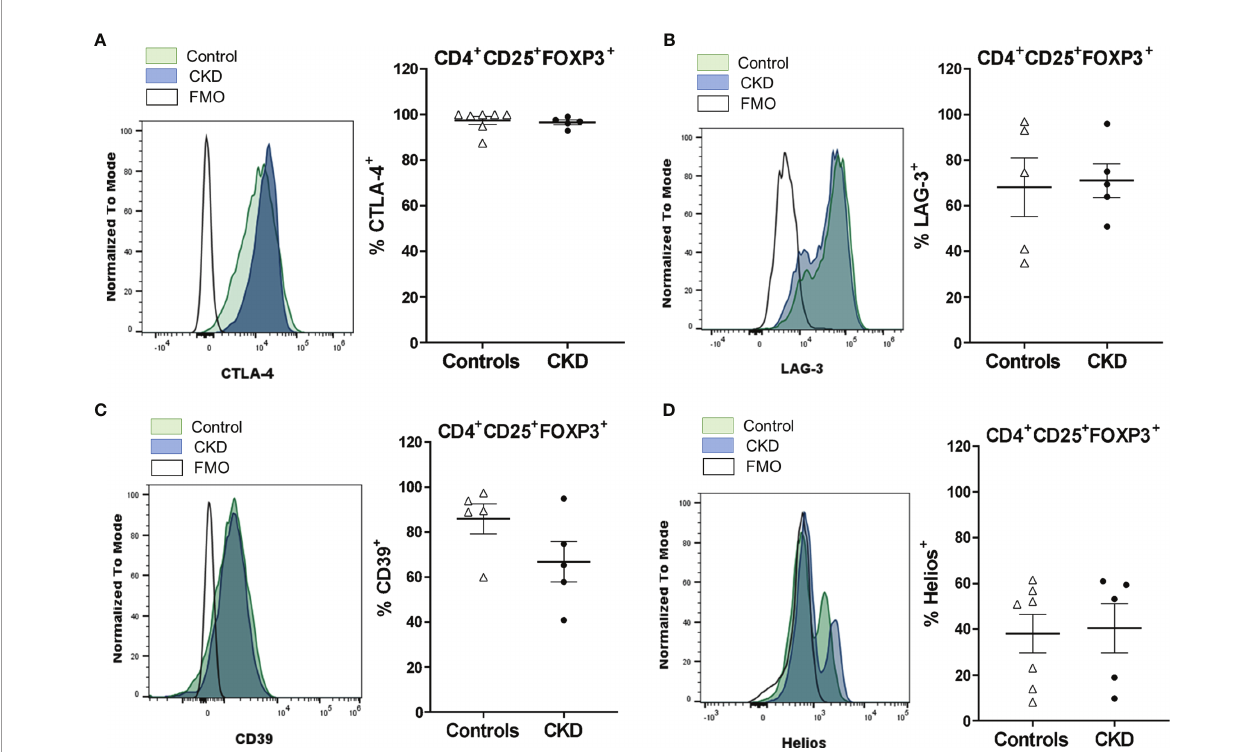
FIGURE 3 | Long-term expanded alloantigen-speci fi c regulatory T cells ( allo Tregs) had high expressions of CTLA-4, LAG-3, and CD39. Highly puri fi ed allo Tregs from healthy controls ( white triangles , n = 5-7) or patients with chronic kidney disease (CKD) ( black circles , n = 5) were polyclonally expanded for 4 weeks and then were stained with fl uorochrome-conjugated antibodies for analysis by fl ow cytometry. (A – D) Analysis of typical Treg markers showed that the expanded allo Tregs from both healthy individuals and patients with CKD had high proportions of CTLA-4 + (A) , LAG-3 + (B) , CD39 + (C) , and Helios + (D) cells. Representative experiments are shown (A – D) , and the white histograms represent FMO ( fl uorescence minus one) controls. The results are shown as the mean ± SEM. Statistical analysis was performed using the Mann – Whitney U test. No signi fi cant differences were